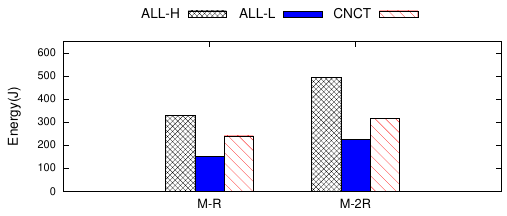
Figure 6. Energy consumption with Memtier